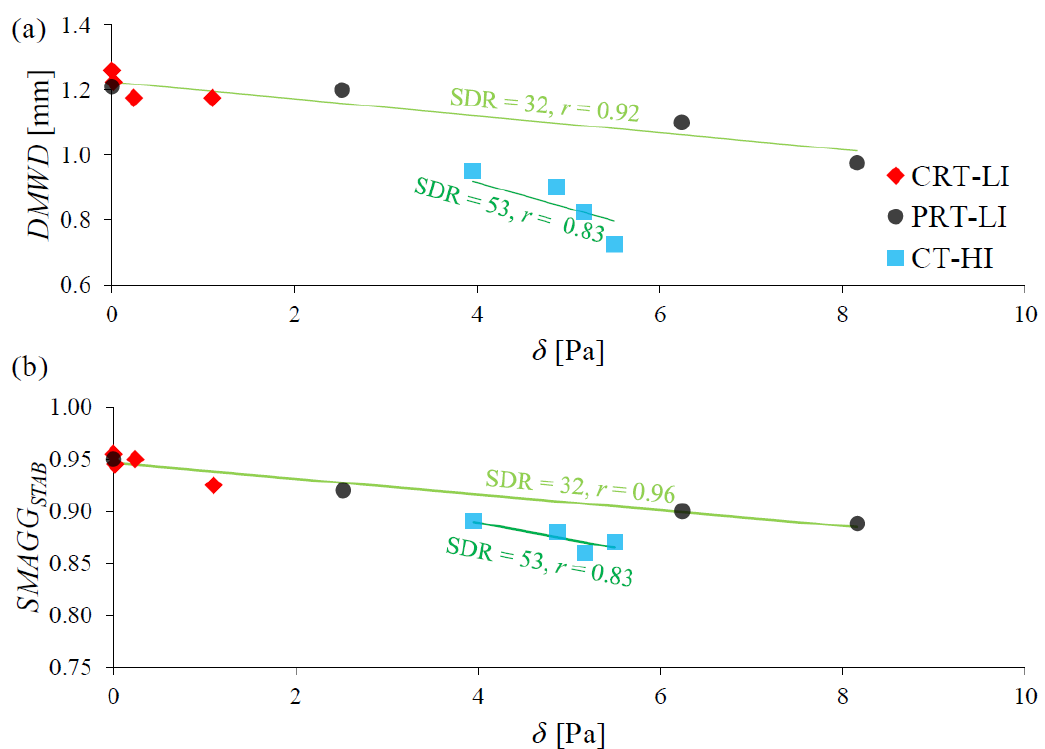
Figure 7. ( a ) relationship between DMWD and local excess shear stress ( δ ); ( b ) relationship between SMAGG STAB and local excess shear stress ( δ ); light and dark green lines represent fitted lines obtained for low tillage intensities (Soil Disturbance Rating = 32) and high tillage intensities (Soil Disturbance Rating = 53), respectively. The Pearson correlation coefficient ( r ) is also shown for each tillage intensity dataset.